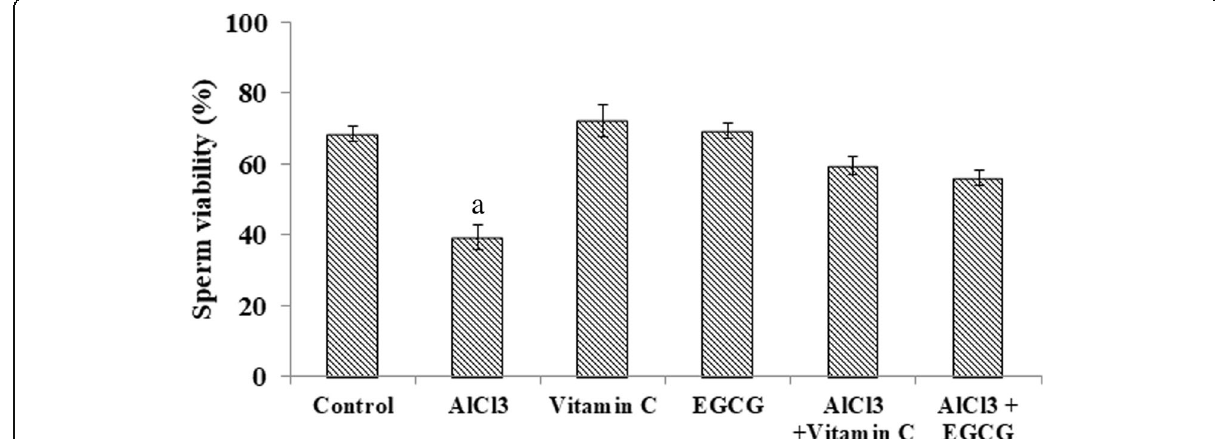
Fig. 6 Effect of EGCG on percentage sperm viability. Values are expressed as mean ± SEM ( n = 6). a P < 0.05 compared with control (one-way ANOVA followed by Tukey ’ s post-hoc test)